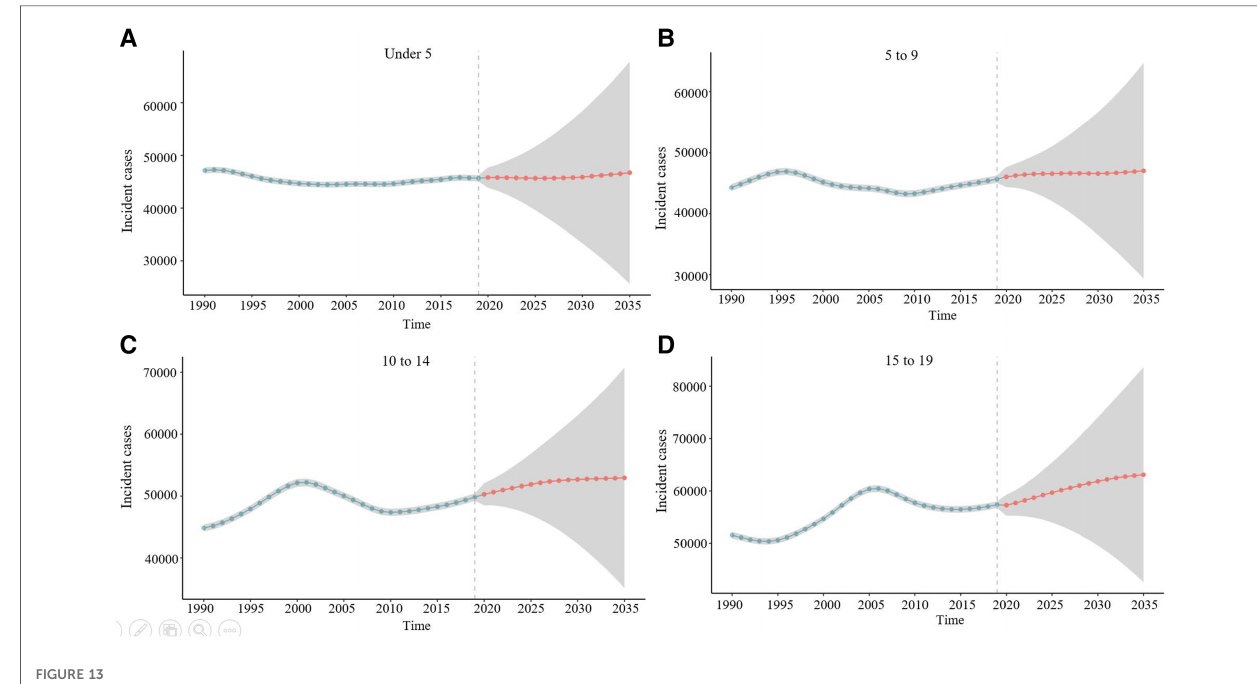
FIGURE 13 Prediction of the incidence rate of childhood myocarditis and cardiomyopathy by age group for 2035. ( A ) Prediction of the incidence rate of myocarditis and cardiomyopathy for under 5-year-olds. The number of cases of myocarditis and cardiomyopathy in 0 – 5 years old children is relatively stable, with the level at about 5,000 cases. ( B ) Prediction of the incidence rate of myocarditis and cardiomyopathy for 5 – 9-year-olds. There would be a slight increase in the incidence of myocarditis and cardiomyopathy in children aged 5 – 9 years. ( C ) Prediction of the incidence rate of myocarditis and cardiomyopathy for 10 – 14-year-olds. The incidence of myocarditis and cardiomyopathy in children aged 10 – 14 is projected to increase by 2035. ( D ) Prediction of the incidence rate of myocarditis and cardiomyopathy for 15 –